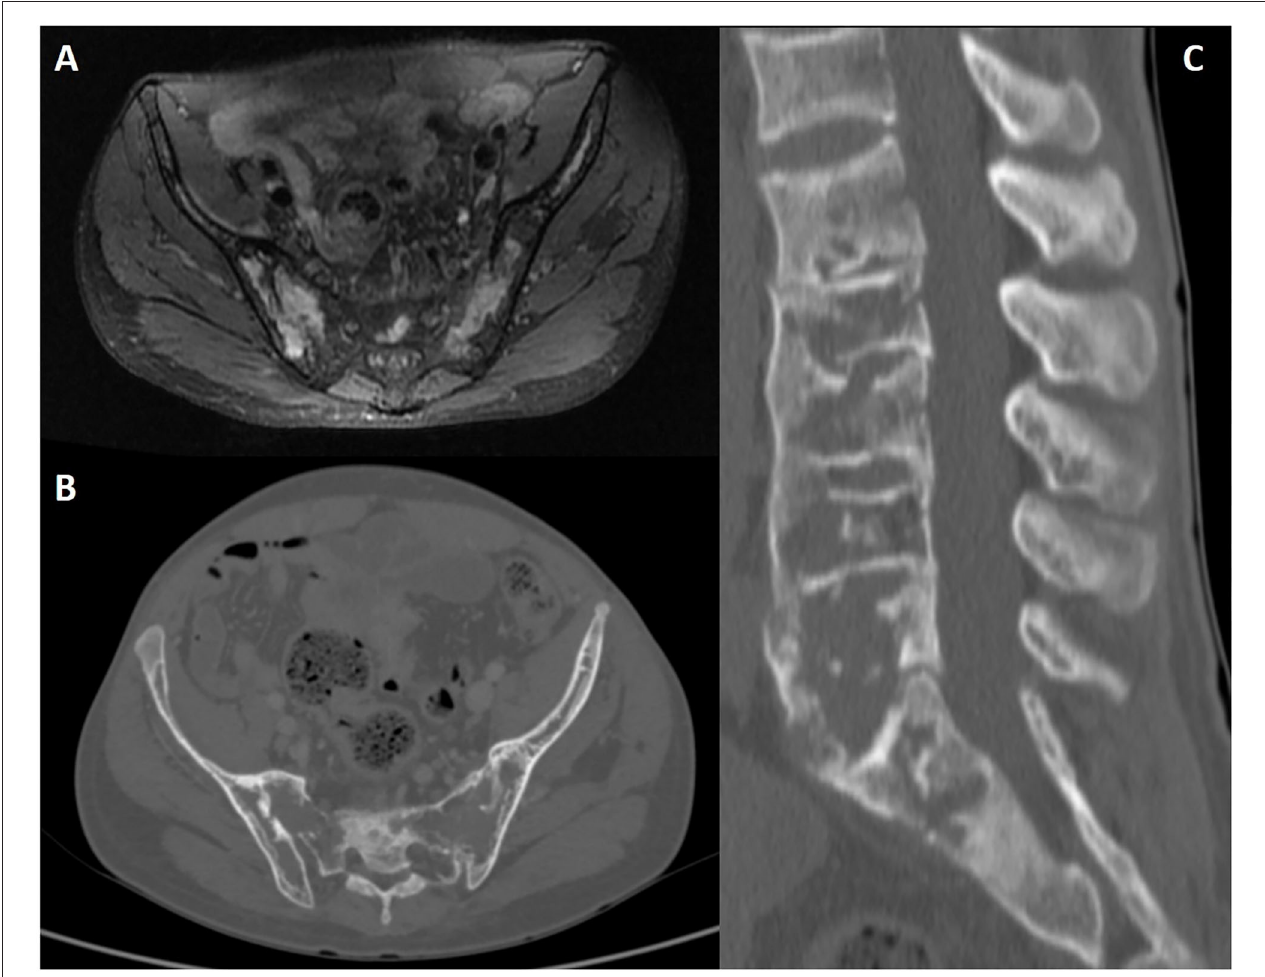
FIGURE 14 | Fat-saturated PD (A) MRI sequence, CT axial slice (B) , and sagittal lumbar spine reconstruction (C) of a 31-year-old male patient with Sickle cell disease and extensive bone marrow changes causing widening of the medullary spaces and thinning of cortical bone.